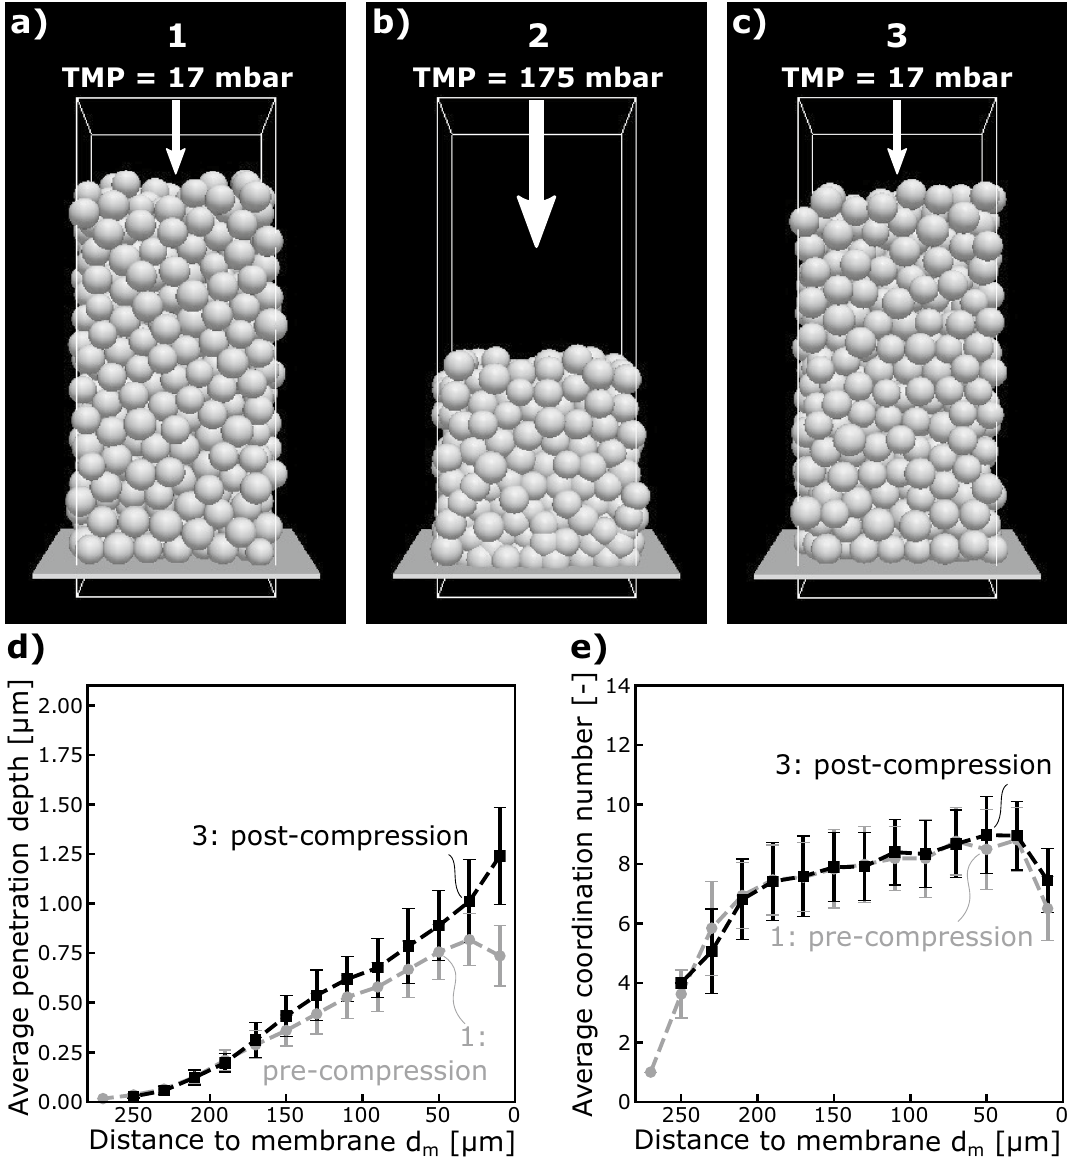
Figure 4. CFD-DEM modeling of cake compression with the visualization of the three conditions ( a – c ). The average penetration depth ( d ) and the average coordination number ( e ) of the particles is compared for the pre- compression (grey circles) and the post-compression (black squares)